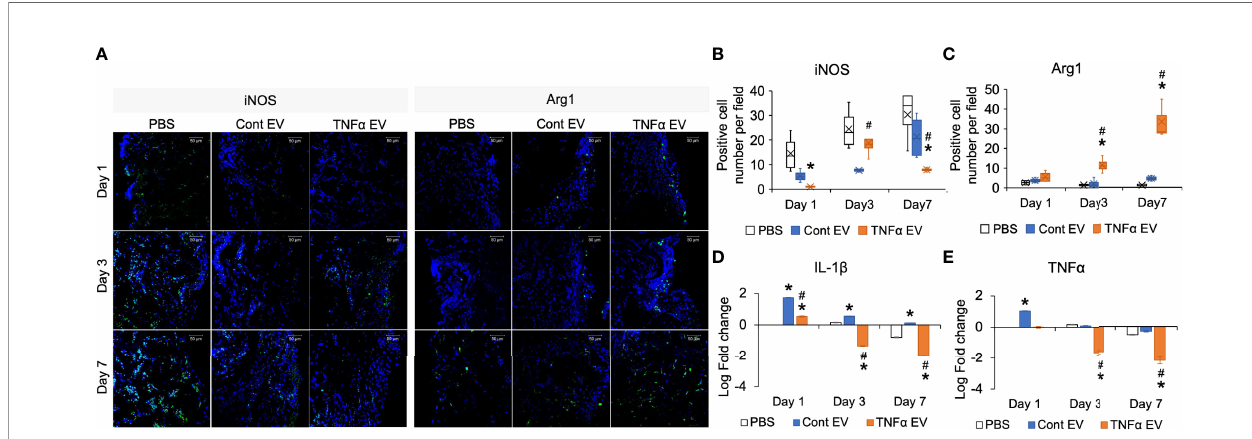
FIGURE 4 | Modulation of in vivo in fl ammatory response by TNF a EVs. (A) Representative confocal images showing IHC staining for pro-in fl ammatory (M1) marker iNOS (green) and anti-in fl ammatory (M2) marker Arg1 (green) in tissue sections from rat calvarial defects 1-, 3- and 7-days post wounding. Scale bar=50 m m in all images. Note the reduced presence of iNOS positive and increased presence of Arg1 positive cells in the TNF a EV group compared to controls. (B, C) Image J based quantitation of number of positive cells per fi eld of view for iNOS and Arg1 expression (n = 5). Note the signi fi cant reduction in iNOS positive cells and increase in Arg1 positive cells. (D, E) Gene expression of IL-1 b and TNF a respectively in tissue samples of calvarial wounds 1, 3 and 7 days post wounding. Data are represented as log 10 of fold change. Note the signi fi cant drop in the expression of these pro-in fl ammatory cytokines in the presence of TNF a EVs with respect to controls. *: statistical signi fi cance (P < 0.05) with respect to untreated control, #: statistical signi fi cance (P < 0.05) between control and TNF a EV groups as calculated by Tukey ’ s test post ANOVA.